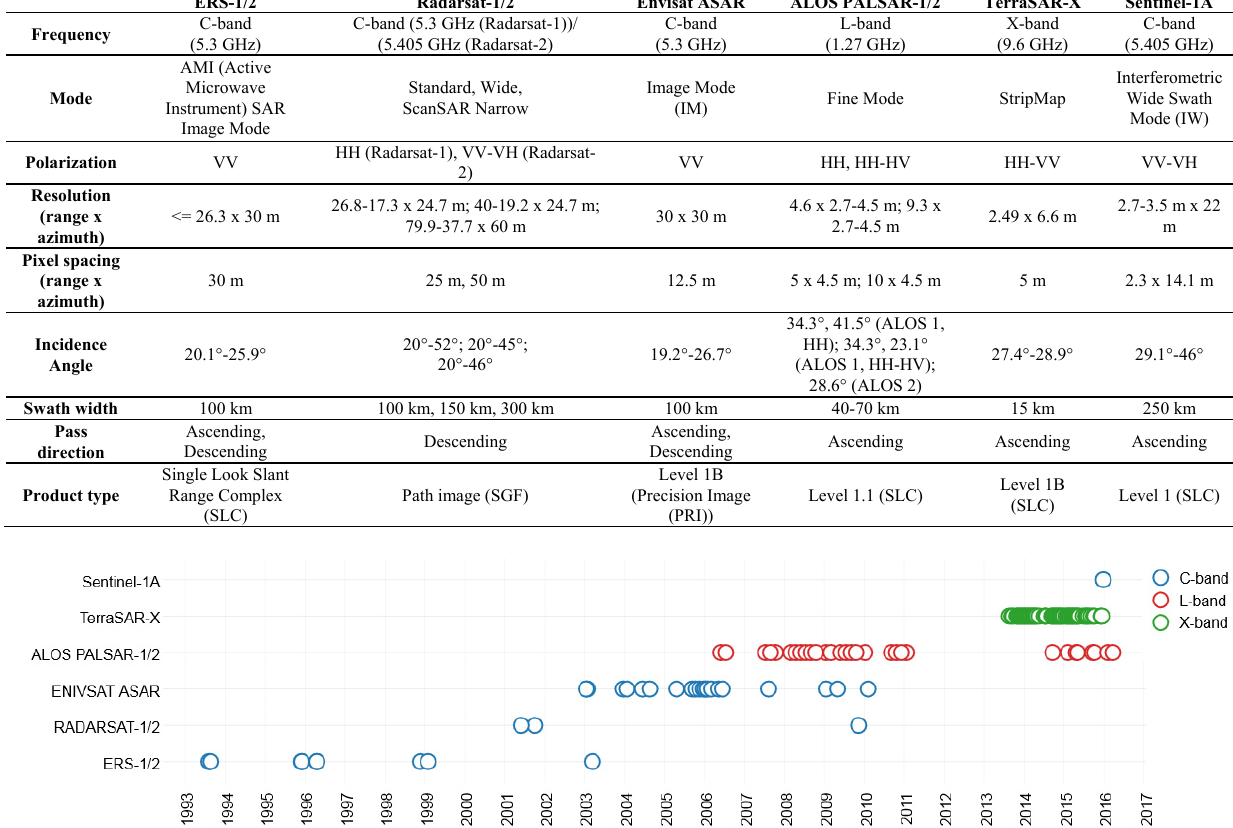
Figure 2. All processed data sorted by sensors and acquisition time from August 1993 to March 2016.